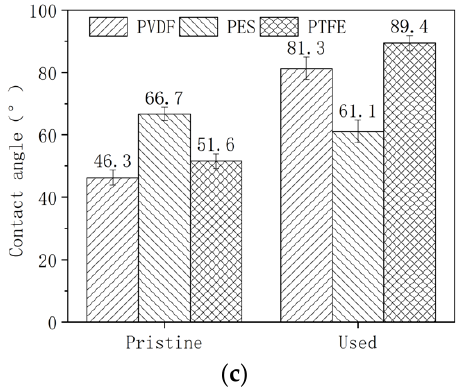
Figure 1. ( a ) Pore size, ( b ) pure water flux, and ( c ) contact angle of the pristine membrane and used membrane from the pilot MBRs.